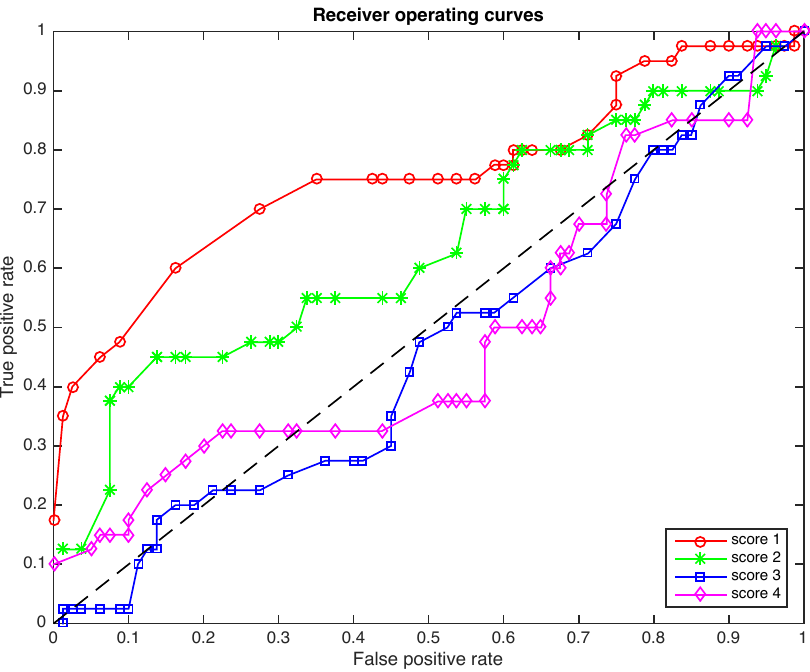
Figure 9. The ROCs for the four scores when the size of the samples to diagnose is ν =